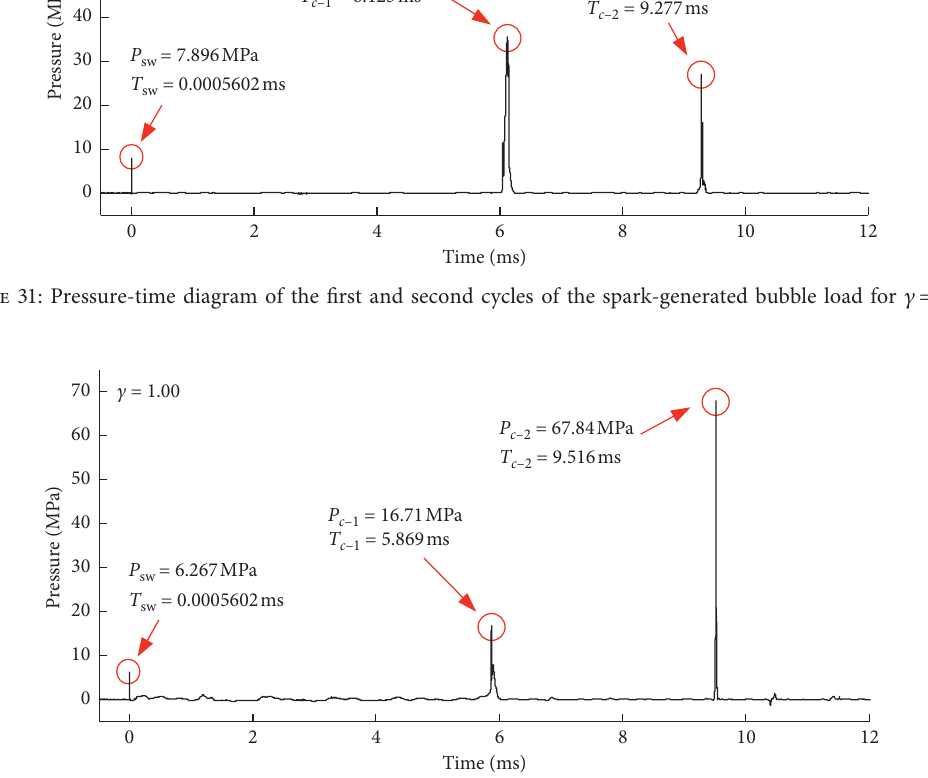
Figure 32: Pressure-time diagram of the first and second cycles of the spark-generated bubble load for c �